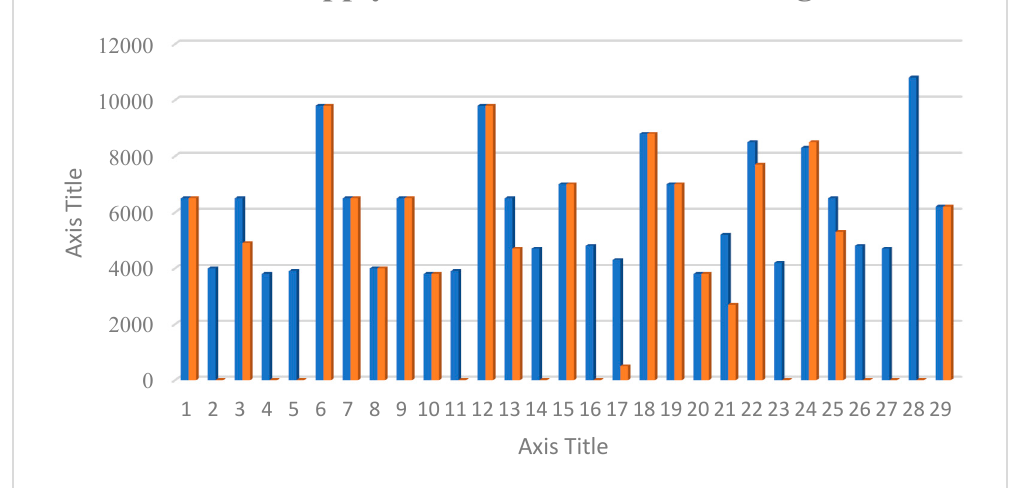
Figure 3. Demand supply status across all the disaster regions with Static RID Model.